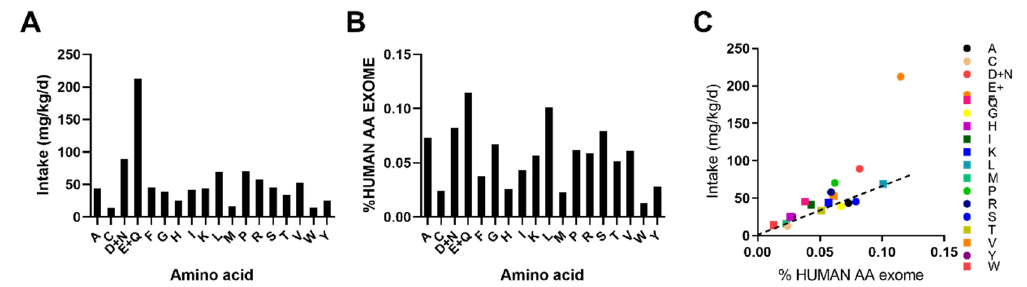
Figure 6. Identification of leucine, methionine, and threonine as potentially limiting essential amino acids with a low-protein intake. A: calculated daily proteinogenic amino acid intake rates during low-protein diet feeding. B: percent representation of AA abundance in the human exome. C: scatter plot of AA intake vs. %AA in the human exome. The dashed line dissects the center of THR, the most limiting EAA.